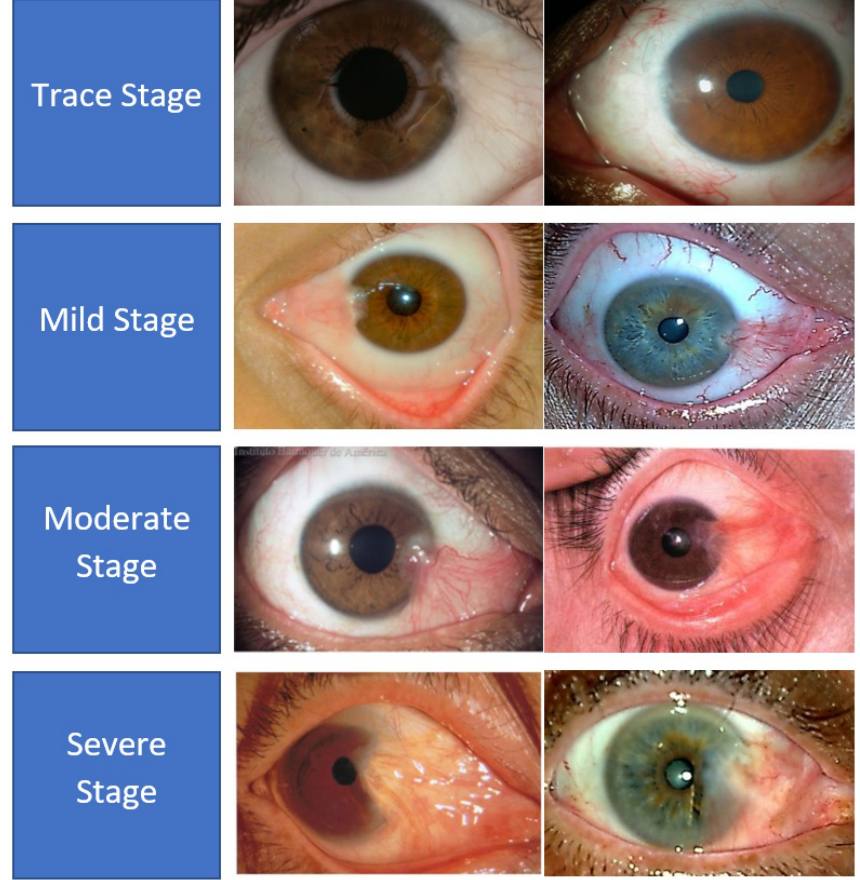
Figure 3. Samples of pterygium-infected tissues according to the severity